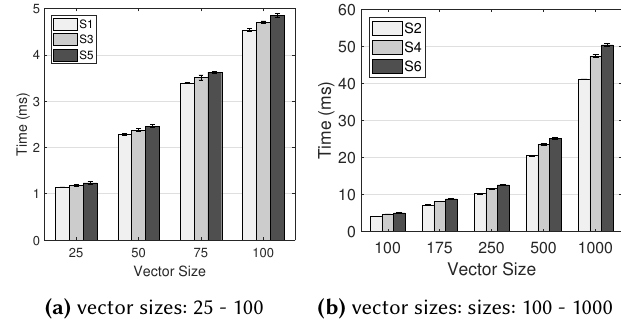
Figure 9. The time spent on initializing the model